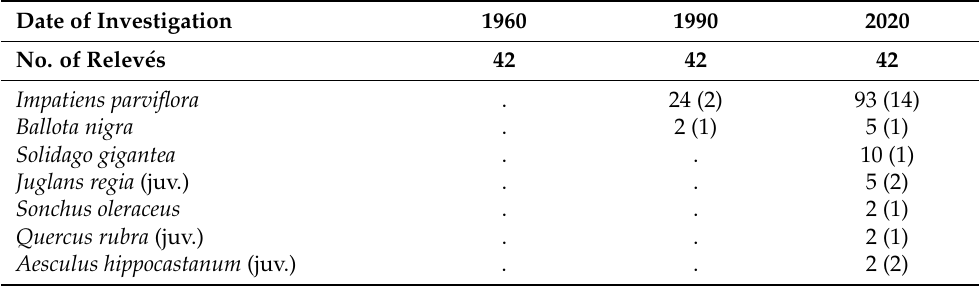
Table 2. Changes in the percentage frequency and percentage mean cover (in brackets) of alien species between three subsequent